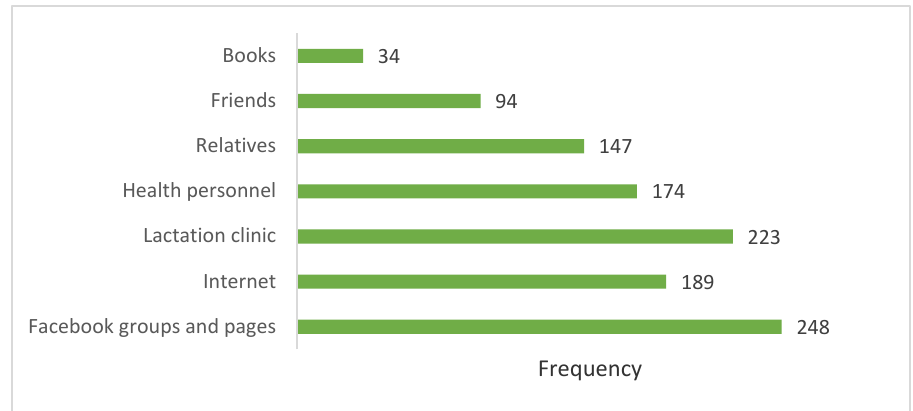
Figure 3. Sources of support/advice when mothers faced breastfeeding difficulties . The top three most common difficulties identified by mothers facing breastfeeding problems were insufficient milk supply, nipple wounds, and sucking problems, as demon- strated in Figure 4.